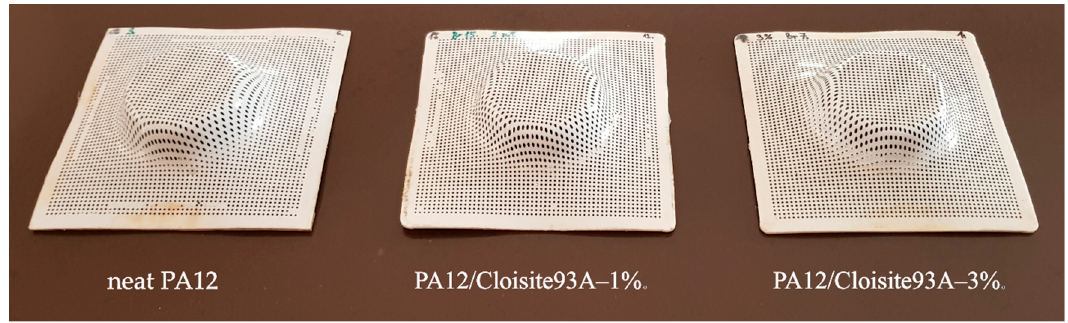
Figure 9. Test parts obtained with SPIF technology: PA12 ( left ), PA12 nanocomposite with 1% clay ( middle ) and PA12 nanocomposite with 3% clay ( right ).